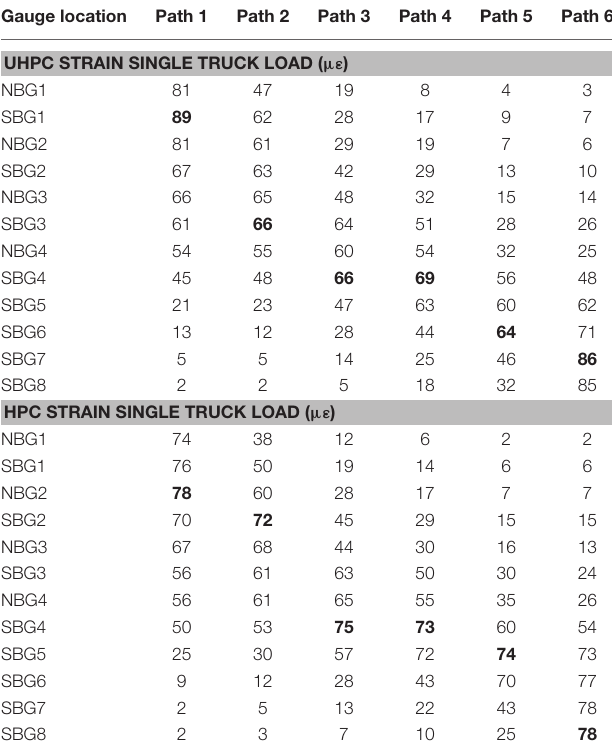
TABLE 5 | Maximum stage 1 load test strains of UHPC and